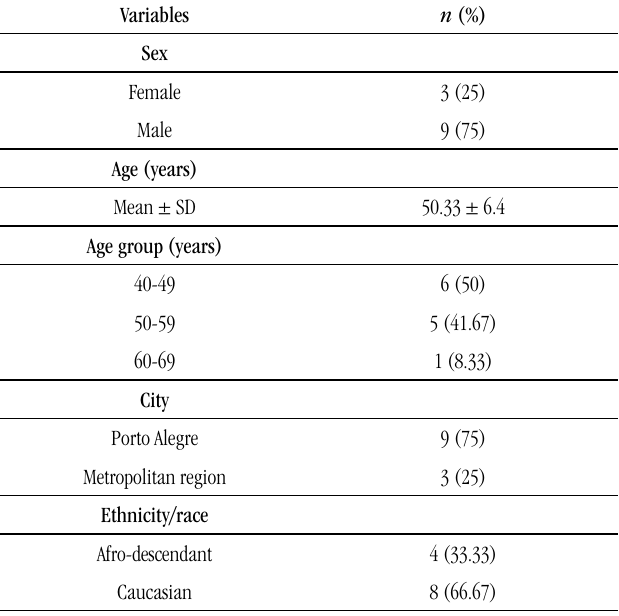
tABLE 3 – Absolute and relative distribution by sex, age group, city and ethnicity/race, and mean age and SD of age for the group of 12 patients with HIV/HCV coinfection (4)